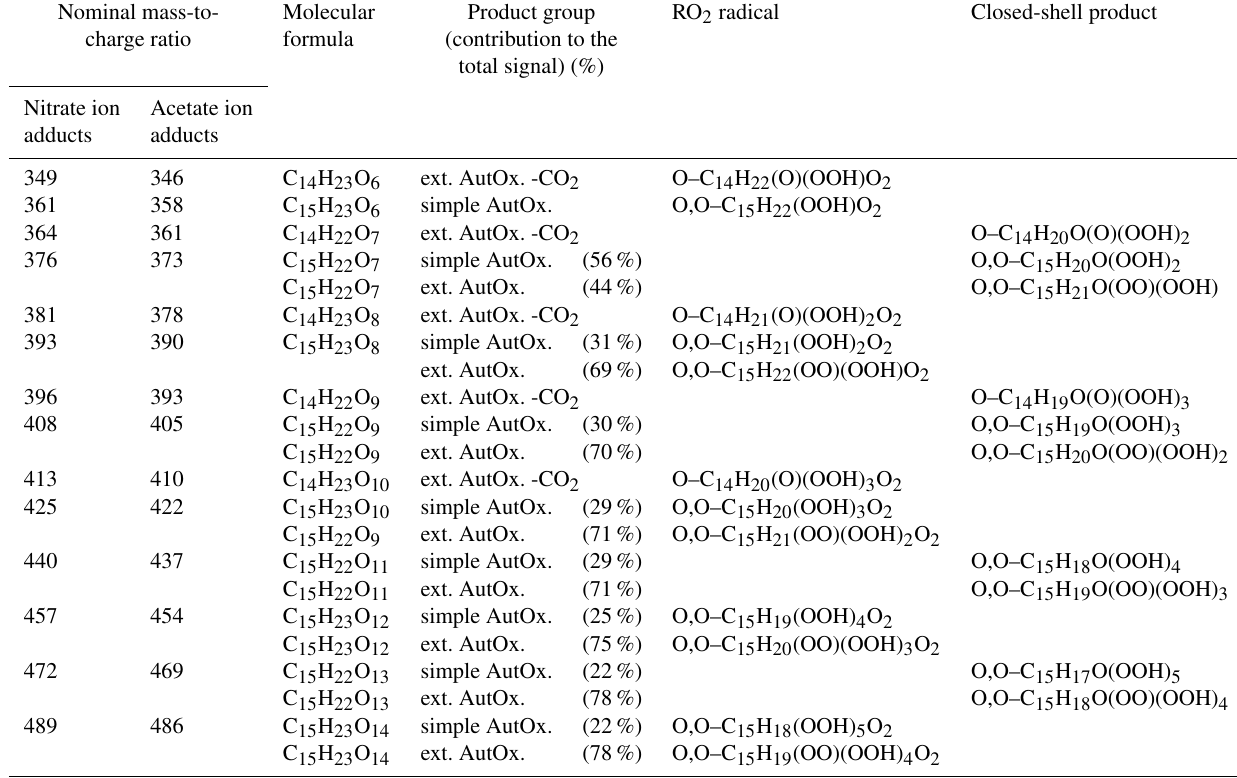
Table 1. Highly oxidized reaction products from the ozonolysis of β -caryophyllene detected as nitrate ion adducts and acetate ion adducts using CI-APi-TOF mass spectrometry. Products were categorized into three product groups, i.e. simple AutOx., ext. AutOx. and ext. AutOx. - CO 2 . Signals from the simple AutOx. and ext. AutOx. groups were detected at the same mass-to-charge ratio. The percentages indicate the contribution of a signal to the different product groups, simple AutOx. and ext. AutOx., as elucidated by H/D exchange experiments using nitrate